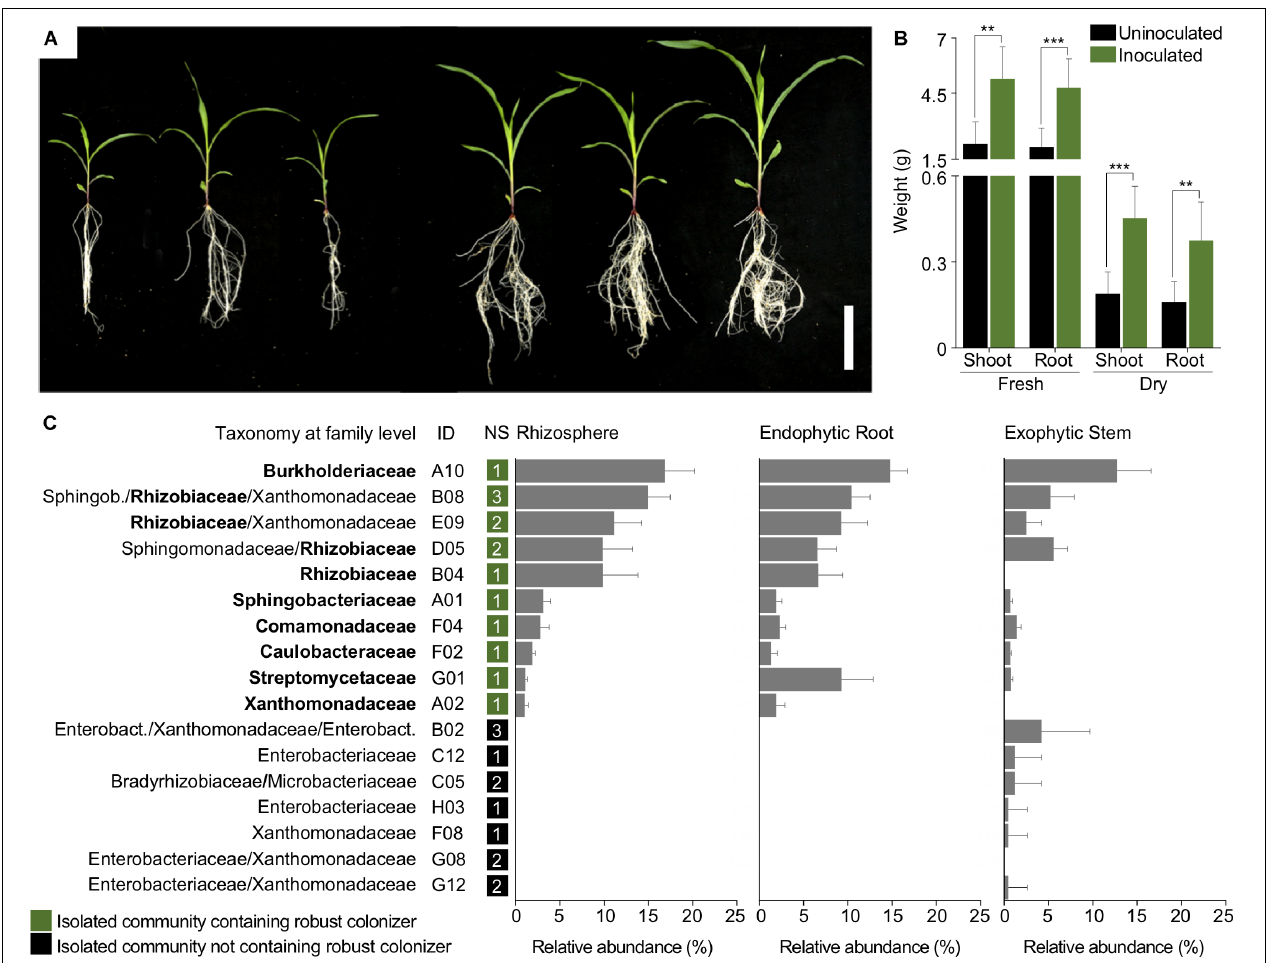
FIGURE 1 | Members of a SynCom promote plant growth and show distinct colonization patterns when inoculated in maize plants. (A) Four-week-old maize plants’ growth in the absence (left) or presence (right) of the SynCom constituted by the 17 community-based isolates of the sugarcane community-based culture collection and (B) its beneficial effect in root and shoot fresh and dry weight. (C) Microbial composition and relative abundances of the 17 community-based isolates in inoculated maize plants. The panel shows, from left to right, the taxonomic classification; ID; number of strains (NS); and relative abundance in the rhizosphere, endophytic root, and exophytic stem for each community-isolate. A family-level classification is shown and those considered as robust colonizers are highlighted in bold. Scale bar: 10 cm. Fresh and dry weight of inoculated and uninoculated plants were compared using Student’s t -test ( ∗∗ p -value ≤ 0.01; ∗∗∗ p -value ≤ 0.001). Colonization was determined by difference in relative abundance of OTUs in inoculated and uninoculated plants using FDR-corrected Kruskal–Wallis test ( P < 0.05). Sphingob., Sphingobacteriaceae; Enterobact.,